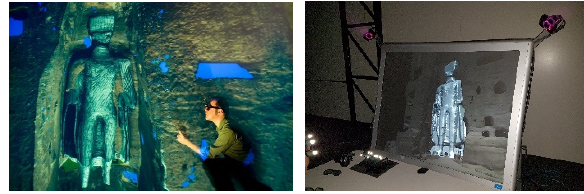
Figure 6. (left): Immersive 3D aixCave System (right): infrared head-tracked 3D workbench